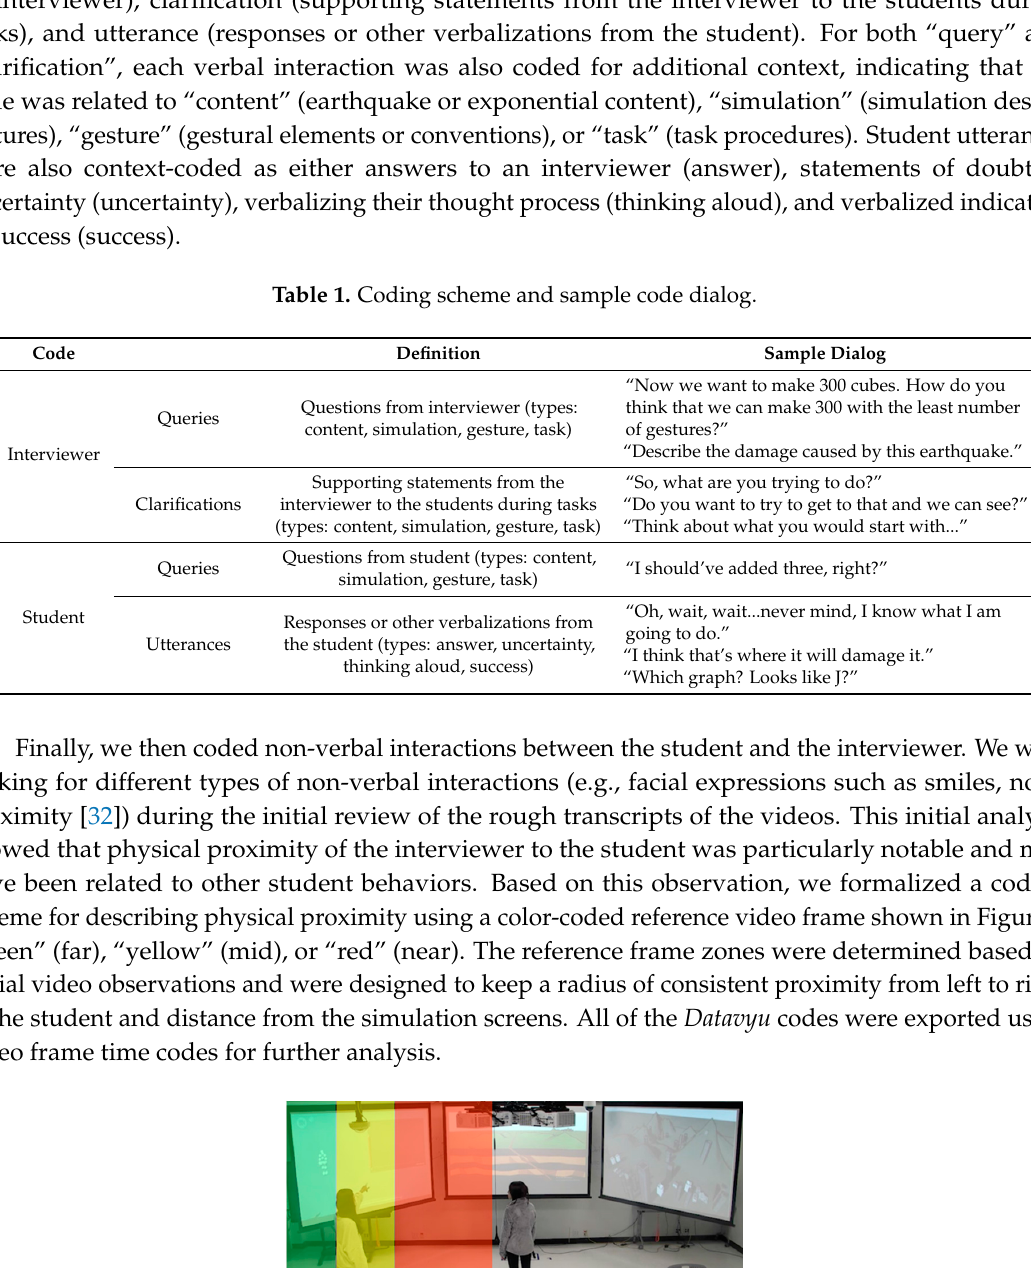
Figure 4. Reference video frame showing interviewer ( left ) and student ( center ) with the color overlay used to code proximity.